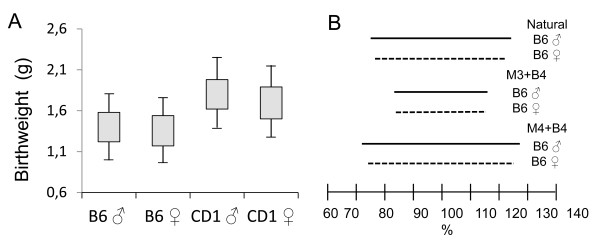
No differences were observed in birth weight variation in male and female CD1 outbred vs B6 inbred mice. (A) Box-Whisker plot indicating mean ± SD (box) and mean ± 1.96 SD (lines). (B) Comparing the full range of random phenotypic variability (4× coefficient of variation) of birth weight in six groups of mice: naturally born male and female B6 mice (top lines), mice born after the simultaneous transfer of five in vivo produced Day 3 morulas (M3) and five Day 4 blastocysts (B4) (middle lines) and mice born after the simultaneous transfer of five in vivo produced Day 4 morulas (M4) and five Day 4 blastocysts (B4) (bottom lines).